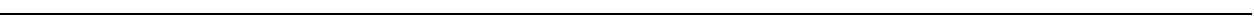
Fig. 1 Adult and cord blood V δ 2 + TCR repertoires are broadly similar. a Tree maps show each adult donor ’ s V δ 2 + TCR repertoire, with each CDR3 clonotype as a coloured segment (each coloured CDR3 segment is chosen randomly and does not match between plots) plotted in relation to the total repertoire size and accompanying clonotype frequency graphs showing the individual clone frequency (left y axis) and the accumulated frequency for the 10 most prevalent clonotypes (right y axis). Inset into each graph are D75 repertoire diversity metrics (measuring the percentage of clonotypes required to occupy 75% of the total TCR repertoire). b Tree maps showing TCR γ and δ CDR3 clonotypes, accumulated frequency graphs and D75 metric from